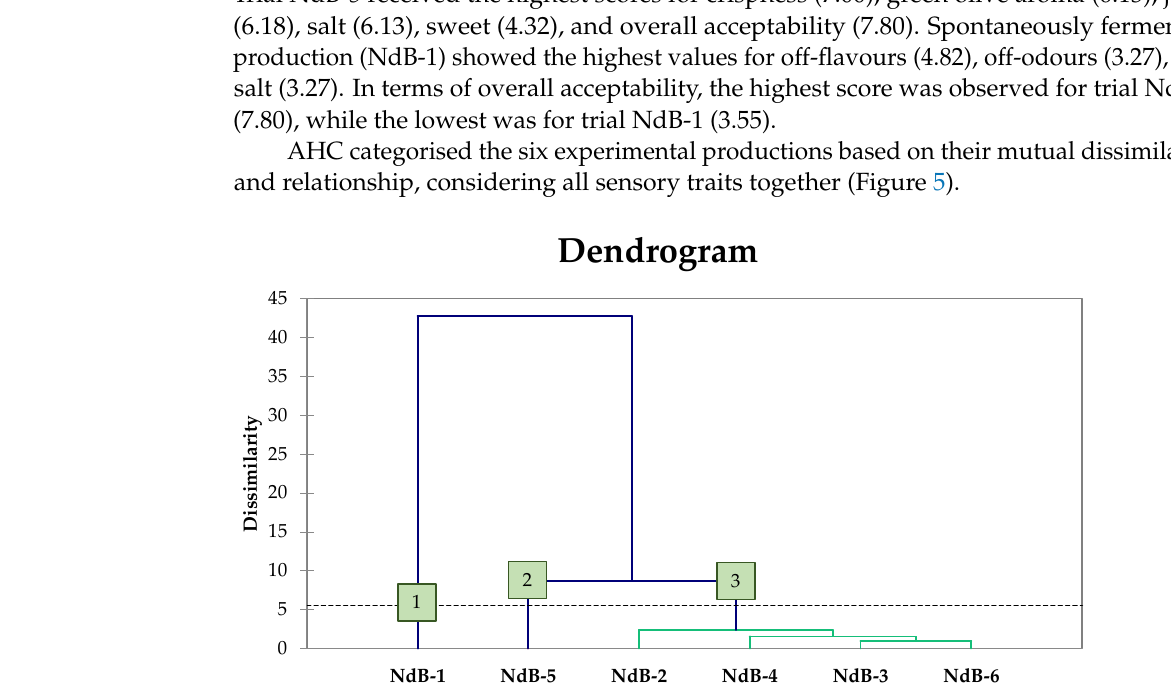
Figure 5. Dendrogram derived from the AHC of table olives based on the values of the attributes assessed during sensory analysis. Abbreviations: NdB-1, spontaneous fermentation; NdB-2, L. pentosus OM13; NdB-3, L. pentosus OM13 + nutrient A; NdB-4, L. pentosus OM13 + nutrient B; NdB-5, L. pentosus OM13 + nutrient C; NdB-6, L. pentosus OM13 + nutrient D. This analysis classified the trials using thirteen variables chosen based on sensory analysis results. With a dissimilarity of 5%, all experimental table olive products were clearly separated into three clusters. Cluster 3 was the most numerous, including four trials (NdB-2, NdB-3, NdB-4, and NdB-6). NdB-1 and NdB-5 represent Clusters 1 and